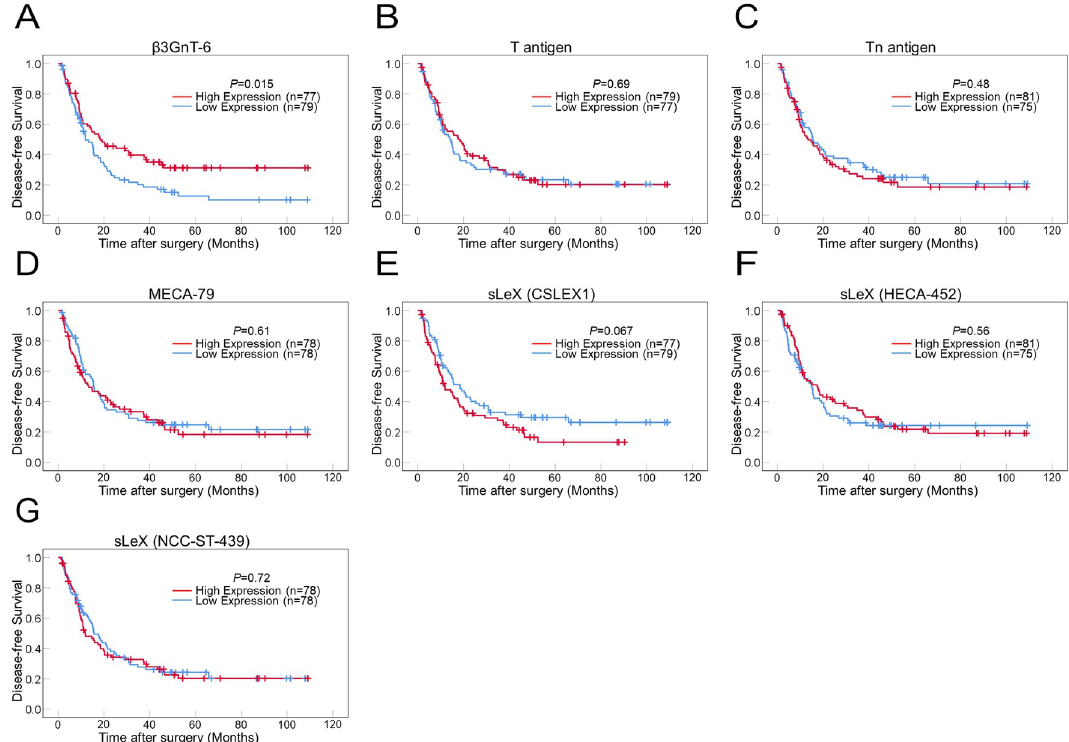
Fig 6. Kaplan-Meier survival curves for disease-free survival in patients with PDAC according to (A) β 3Gn-T6, (B) T antigen (PNA), (C) Tn antigen (LU-35), (D) 6-sulfo N -acetyllactosamine on extended core 1 O -glycan (MECA-79), (E) sLeX (CSLEX1), (F) sLeX (HECA-452), and (G) sLeX on core 2 O -glycan (ST-439). Patients having PDAC with higher expression of β 3Gn-T6 (red line) show a significantly longer survival compared to those with lower expression of β 3Gn-T6 (blue line) in A. Patients having PDAC with higher expression of sLeX (CSLEX1) (red line) show a tendency to be shorter survival compared to those with lower expression of sLeX (CSLEX1) (blue line) in E. The other antigens are not significantly associated with patient outcome.